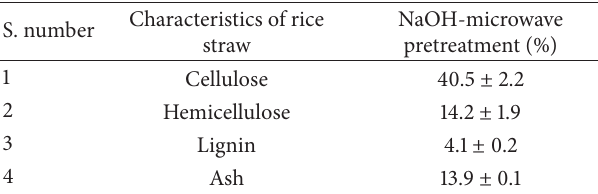
Table 5: Chemical composition of rice straw after pretreatment.